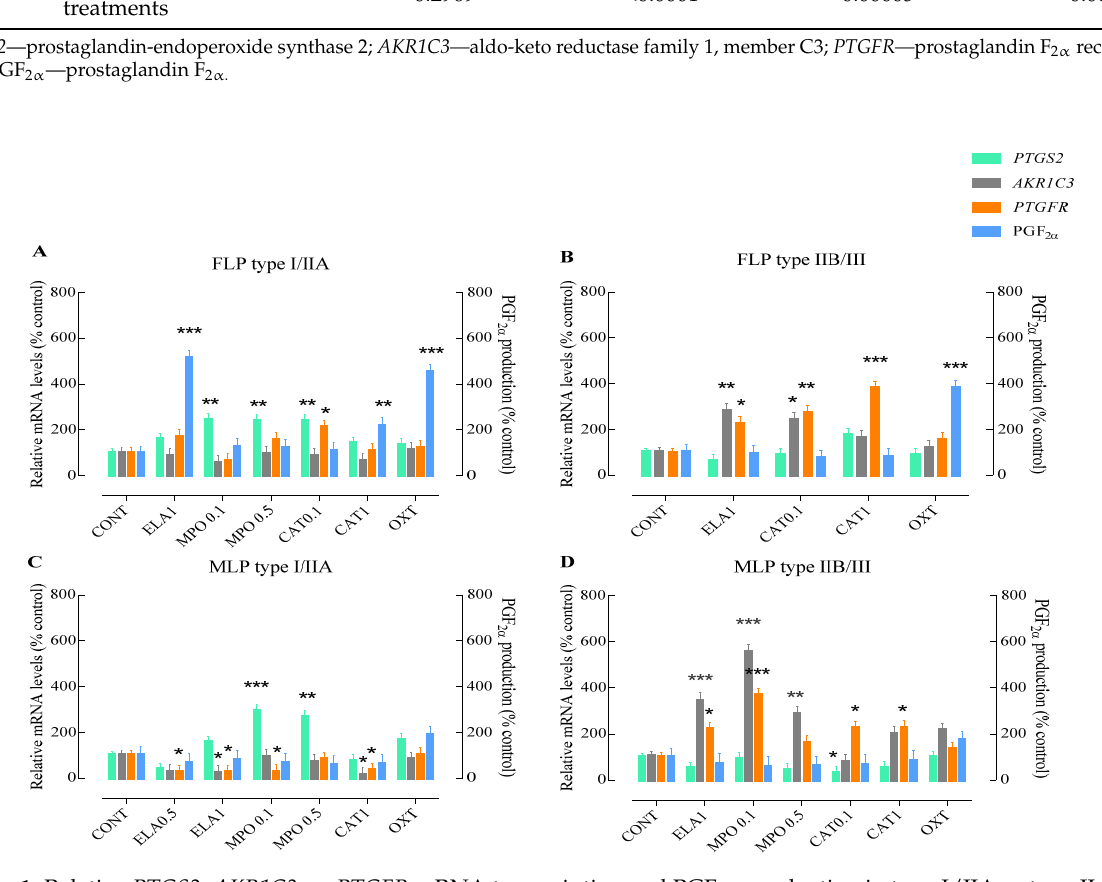
Figure 1. Relative PTGS2 , AKR1C3 , or PTGFR mRNA transcription and PGF 2 α production in type I/IIA or type IIA/III follicular